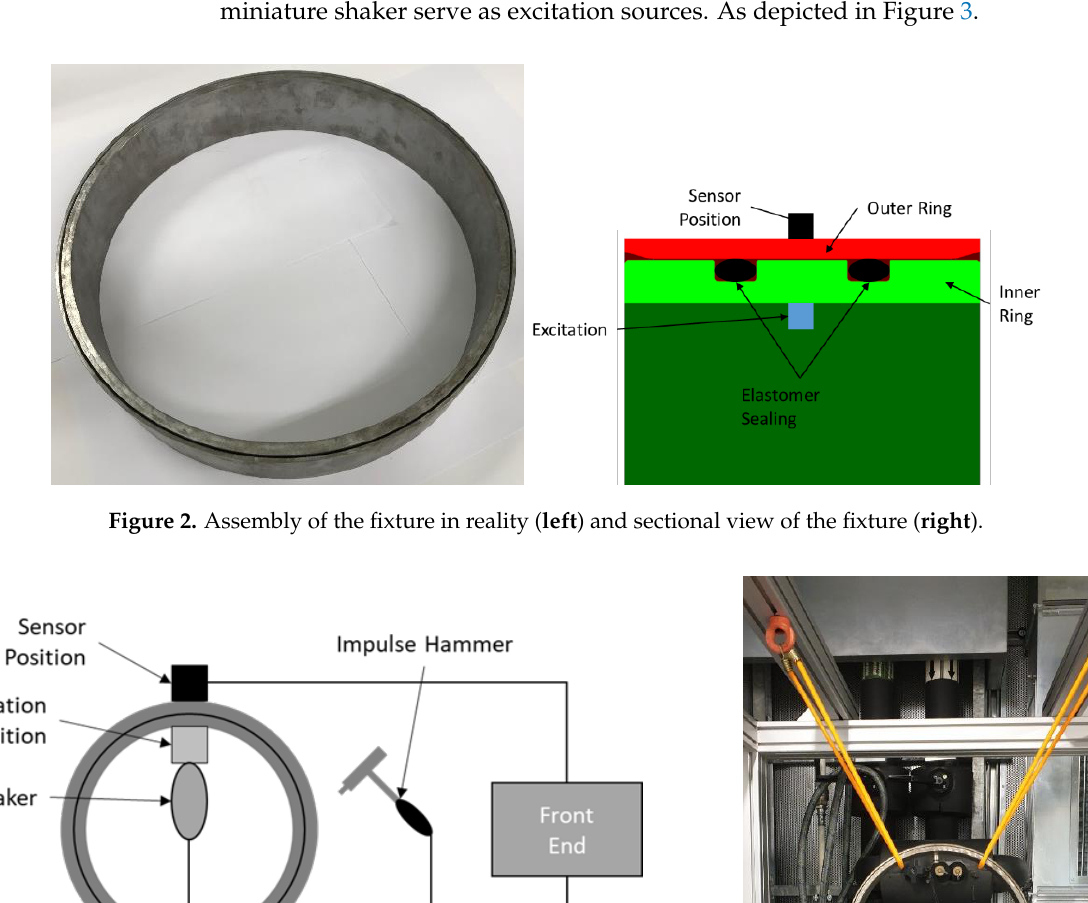
Figure 2. Assembly of the fixture in reality ( left ) and sectional view of the fixture ( right ).